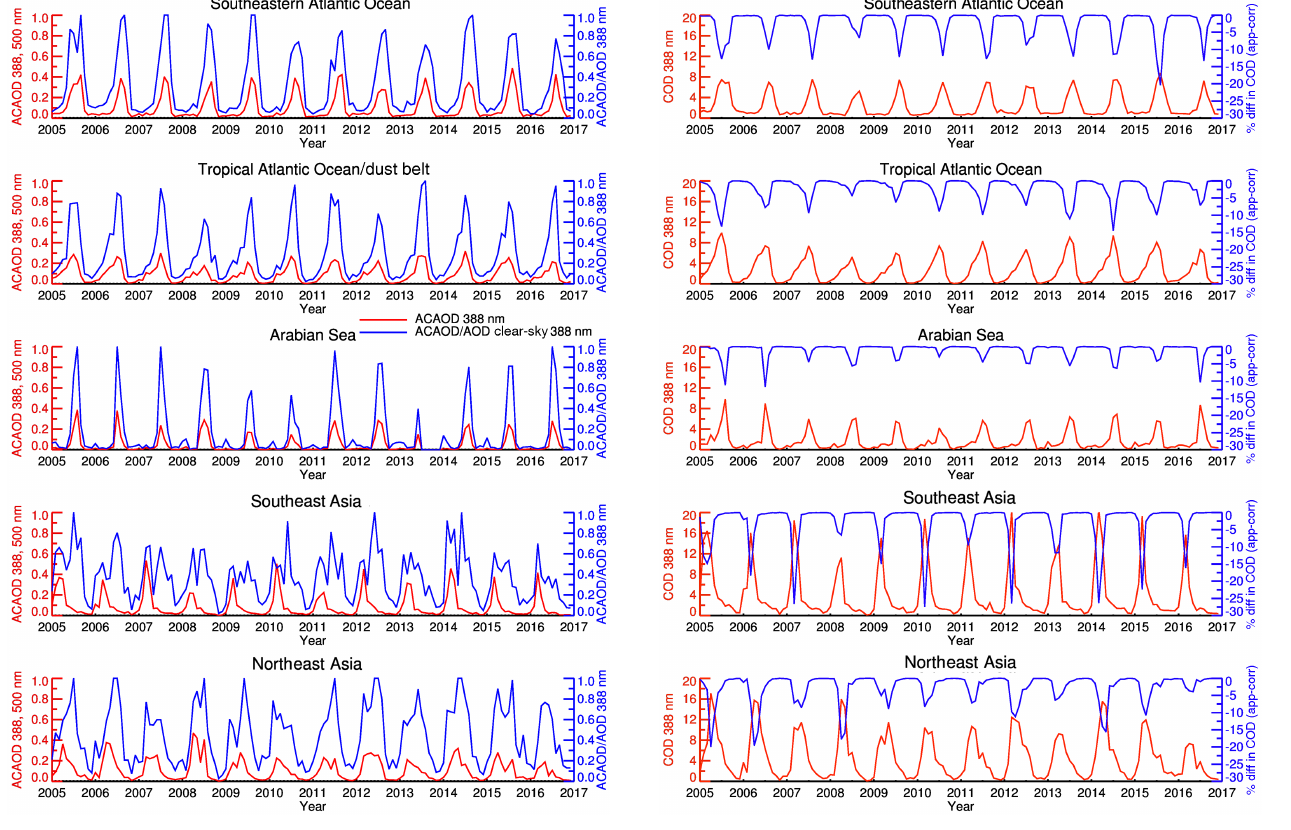
Figure 9. Time series of regional monthly mean above-cloud AOD at 388nm (left y axis, color: red) and the ratio of above-cloud AOD and cloud-free AOD (right y axis, color: blue), both at 388nm, de- rived using the OMACA and OMAERUV products, respectively.